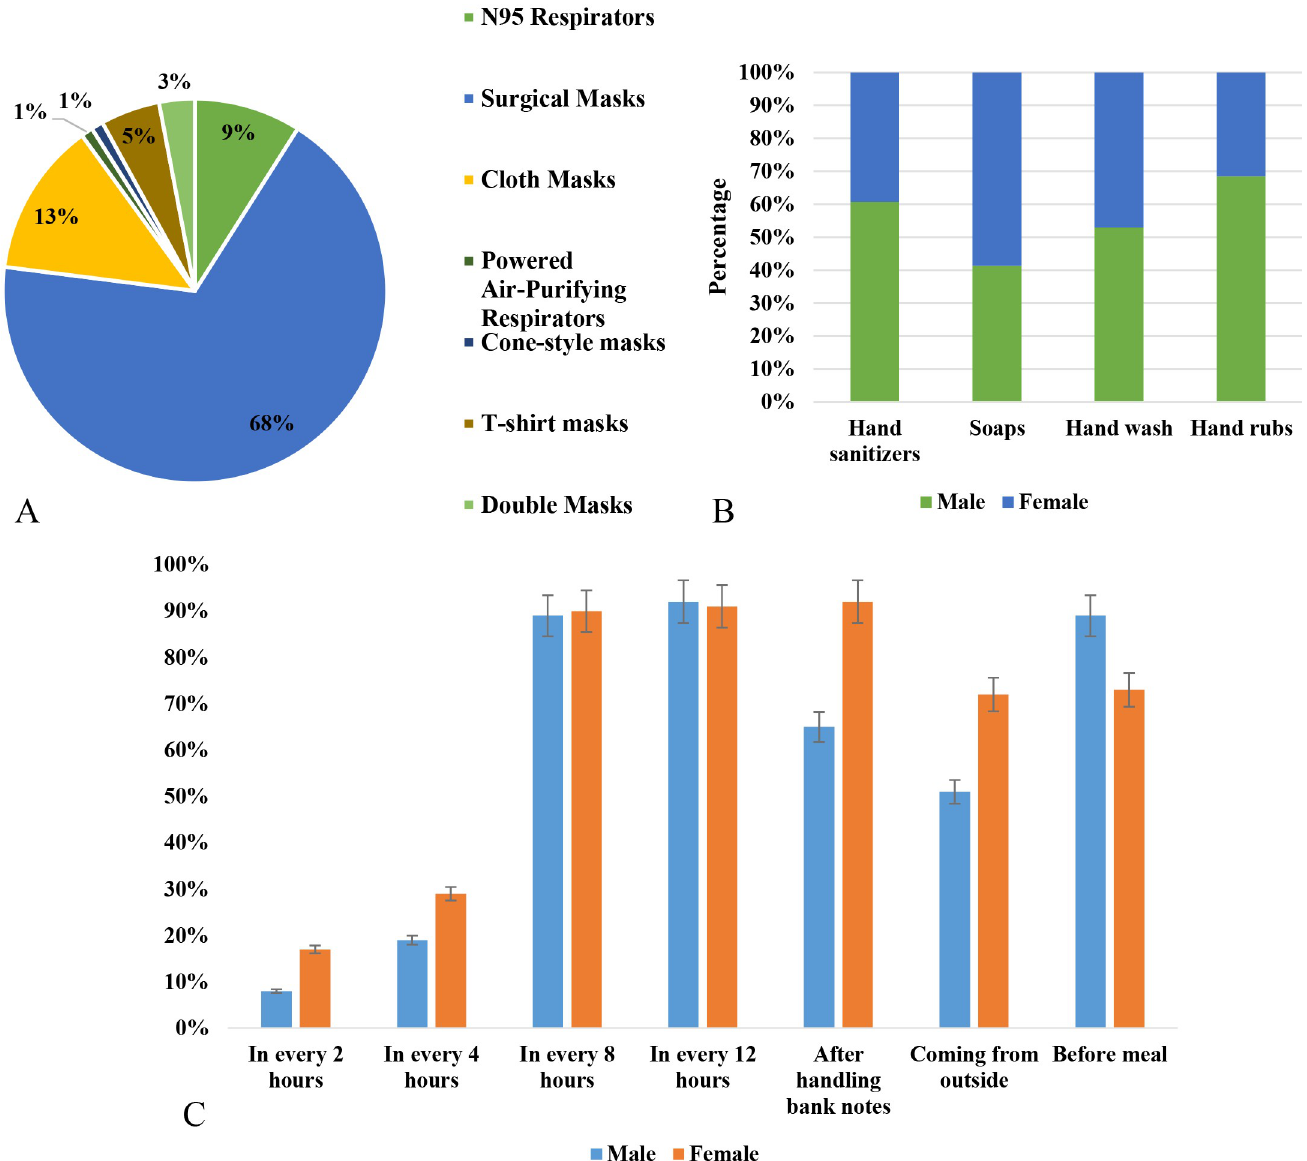
Fig 2. A. Trends of the participants to use different types of face masks, B. Gender distribution of the practices of using different types of hand sanitizing media, C. Frequency distribution of the practices of hand cleaning among male and female in Bangladesh.